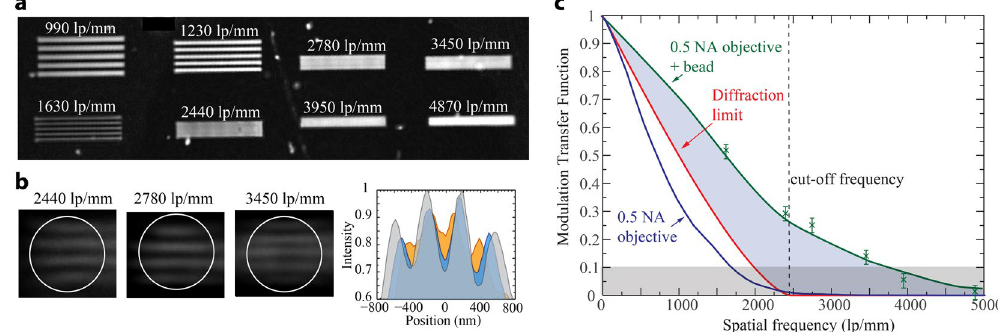
Figure 2. Optical response in a microbead coupled to a bright-field microscope. ( a ) Optical micrograph acquired with the 50 × objective of gratings imaged without the microbead. ( b ) Details of three gratings imaged through the microbead. Note that these frequencies could not be resolved without the microbead. The corresponding intensity profiles (normalized with respect to 2440 lp/mm) are also shown. ( c ) Frequency response of the microscope with and without microbead. The response from a diffraction limited system has also been included. The gray area indicates the 10% MTF criterion used to define the maximum attainable resolution. The highlighted purple area indicates the enhancement in resolution achieved with the microbead with respect to a perfect diffraction-limited system with a 0.5 NA. The cut-off frequency indicates the Abbe resolution limit for a 0.5 NA